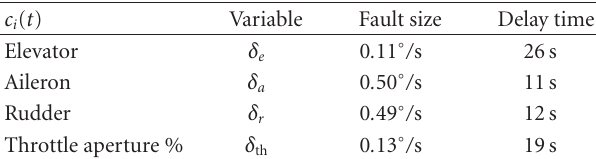
Table 3: PM FDI technique: minimal ramp faults with ν = 4.